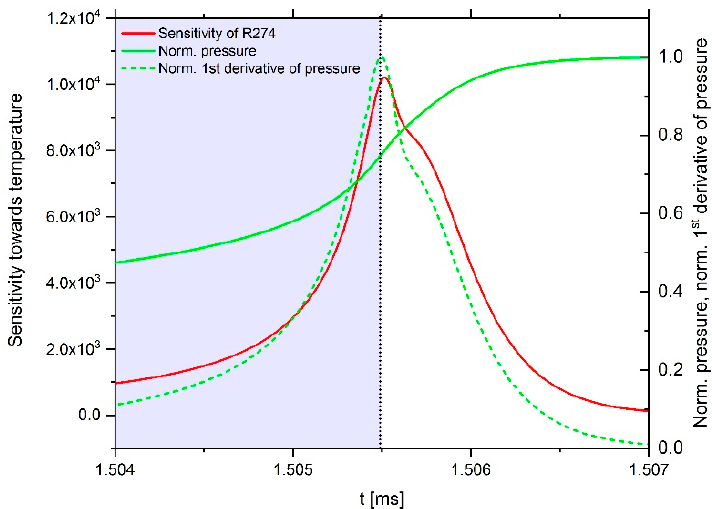
Figure 7. Simulated time-dependent sensitivity towards temperature of the reaction 274 (C 7 H 16 + OH ↔ H 2 O + n -C 7 H 15 ) and the pressure profile in the area of ignition calculated at 800 K and 60 bar, using mix 9 from Table 1.